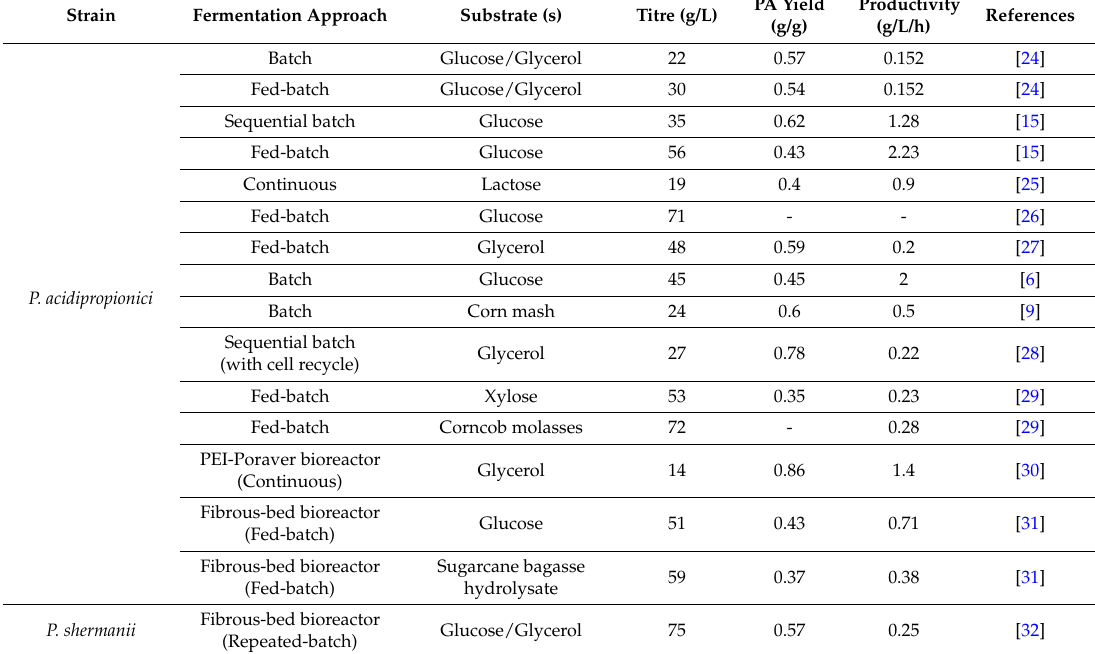
Table 2. Comparison of some propionic acid (PA) fermentation approaches from the literature dating 2010 to